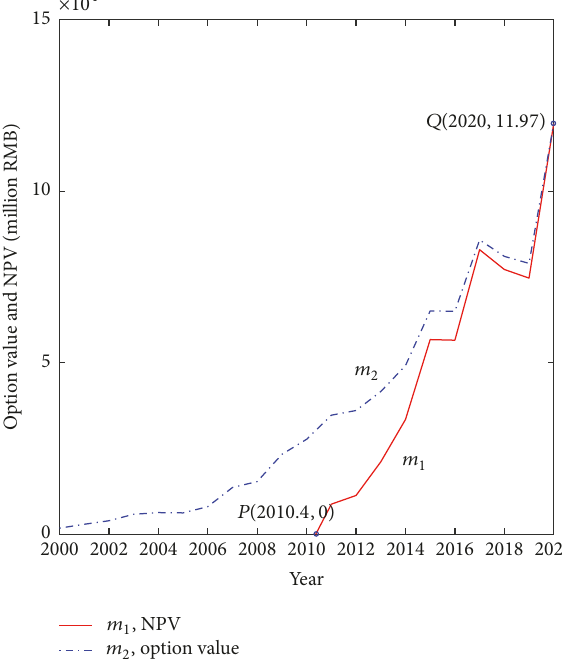
the geometric Brownian motion, as indicated on the right- hand side of Figure 8.